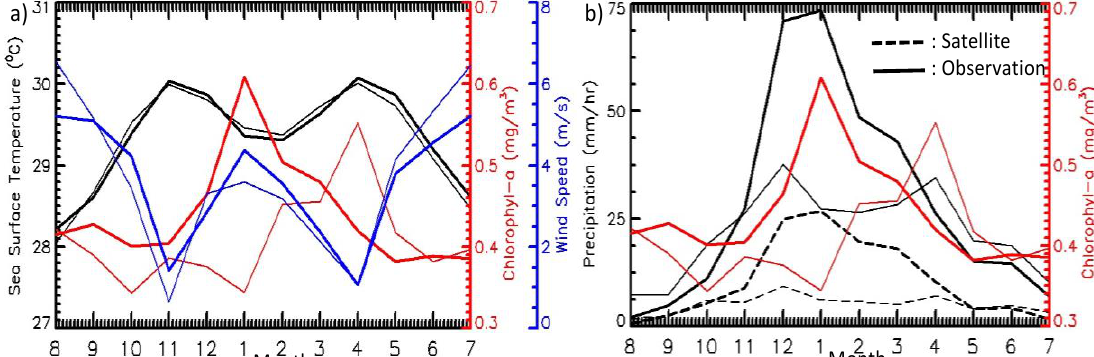
Figure 4. Temporal variation of ( a ) SST, Chl-a, and wind speed; and ( b ) precipitation and Chl-a. Thin and thick lines represent the thin and thick boxes in Figure 3a. The observational data of precipitation are derived from meteorological stations at Majene Regency (blue dot) and Makassar City (red dot), as shown in Figure 1b. For precipitation derived from satellite, the averaging area includes the land area, as shown by the extension of boxes in Figure 3a.